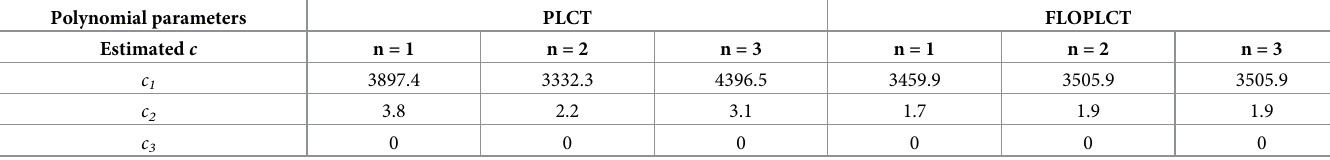
Table 5. The estimated polynomial parameters of the bearing ball fault in the position of DE data contaminated α stable distribution noise ( MSNR = 16 dB , α = 0.8) employing the PLCT and FLOPLCT methods ( n = 3). Polynomial